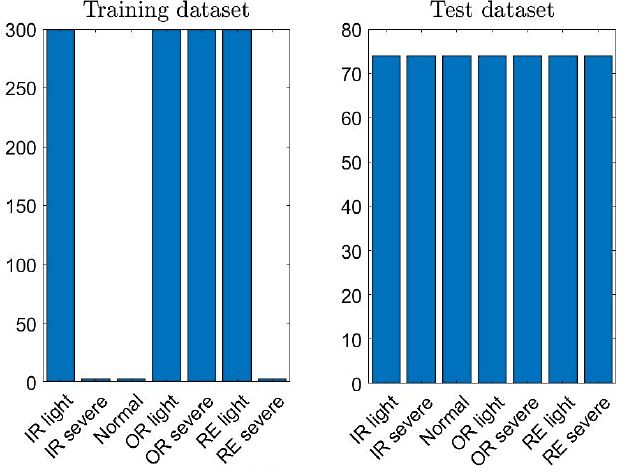
Figure 9. Network behavior when training with four classes, but it successfully identifies seven clas- sification categories.